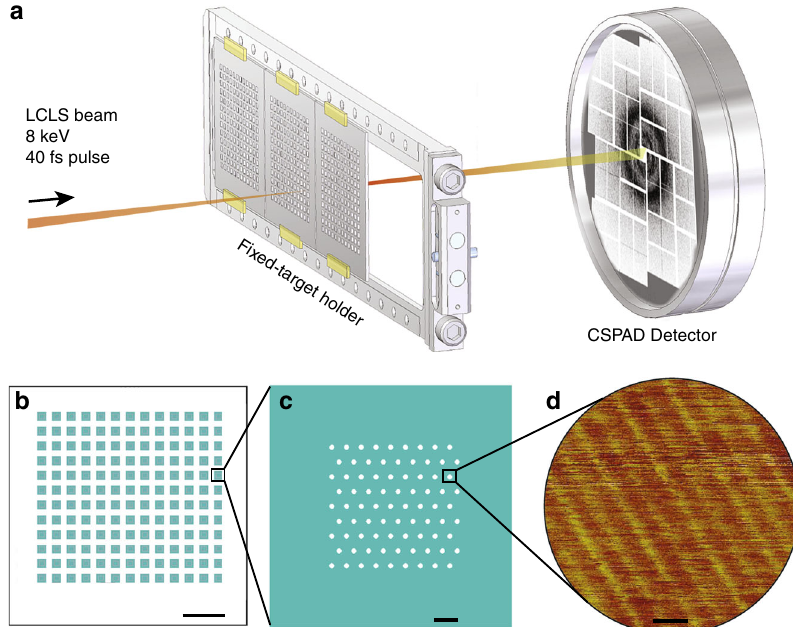
Fig. 1 Experimental overview. a Silicon chips covered with a monolayer of graphene and a layer of fi brils were mounted in vacuum at the CXI beamline at LCLS and scanned through the XFEL focus. b Fixed-targets were made of a square silicon frame patterned with an array of 12 × 13 windows. Scalebar is 5 mm. c A single window contained 81 holes of either 20 or 30 μ m in diameter arrayed on a hexagonal lattice, resulting in 12,636 holes over a 2.54 × 2.54 cm area. Scalebar is 100 μ m. d An atomic force microscope image of a hole covered with graphene and fi brils is shown. Fibrils were imaged next to the hole on the silicon frame, as tapping without the support destroys the graphene layer. Scalebar is 20